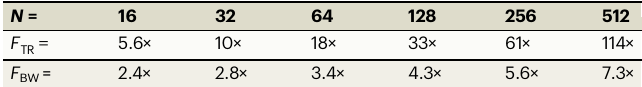
Table 2 | Characteristics of the major tunable crossing types